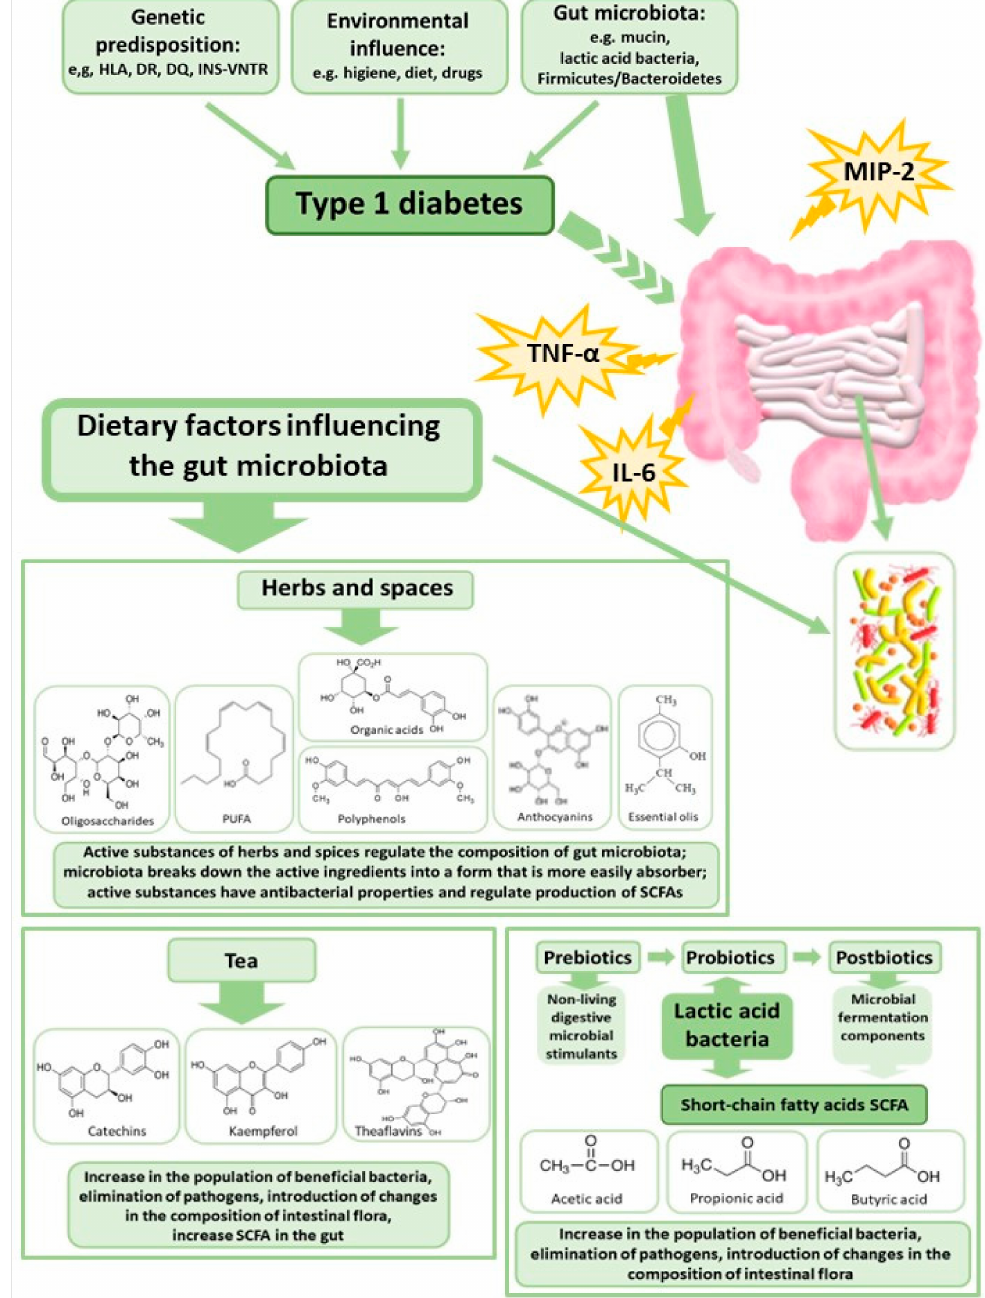
Figure 2. Dietary factors modulating gut microbiota in the case of type 1 diabetes. SCFA—Short- chain fatty acids, TNF- α —tumor necrosis factor- α , MIP-2—Macrophage Inflammatory Protein 2, IL-6—interleukin-6, PUFA—Polyunsaturated fatty